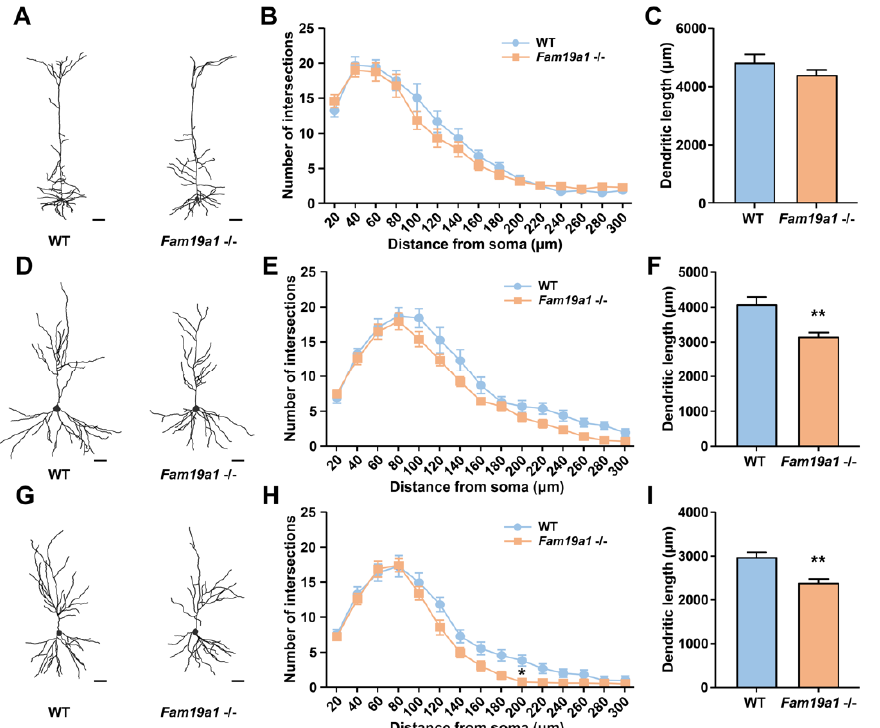
Figure 3. Dendritic morphology of pyramidal neurons in adult Fam19a1 − / − mice (postnatal day 63). ( A – C ) Morphological analysis on pyramidal neurons of cortical layer 5 (L5). ( A ) Representative images of reconstructed cortical L5 pyramidal neurons. Scale bars represent 50 μ m. ( B ) Sholl analysis and ( C ) total dendritic length of cortical L5 pyramidal neurons in wild-type (WT) and Fam19a1 − / − mice. ( D – F ) Morphological analysis on pyramidal neurons of CA1 in the hippocampus. ( D ) Representative images of reconstructed CA1 pyramidal neurons. Scale bars represent 50 μ m. ( E ) Sholl analysis and ( F ) total dendritic length of CA1 pyramidal neurons WT and Fam19a1 − / − mice. ( G – I ) Morphological analysis on pyramidal neurons of CA3 in the hippocampus. ( G ) Representative images of reconstructed CA3 pyramidal neurons. Scale bars represent 50 μ m. ( H ) Sholl analysis and ( I ) total dendritic length of CA3 pyramidal neurons in WT and Fam19a1 − / − mice. For each experimental group, three mice were subjected for analysis. Data are presented as means ± standard errors of means (SEM). * p < 0.05, ** p < 0.01 versus WT mice by Mann–Whitney tests with Bonferroni correction.